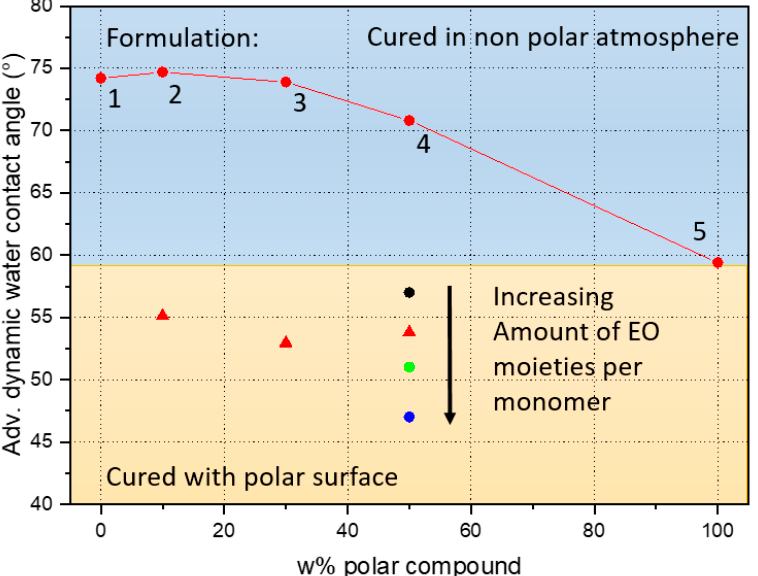
Figure 2. Evaluation of the effect of the chemical composition of the thiol polymer prototypes on its hydrophilicity, measured by the advancing dynamic contact angle. Formulations with a varying polar components content are shown in red dots for a 10%, 30% and 50%, all with WCA below 57°, when cured in contact with a polar surface (i.e., using a non-structured Ormocomp stamp).